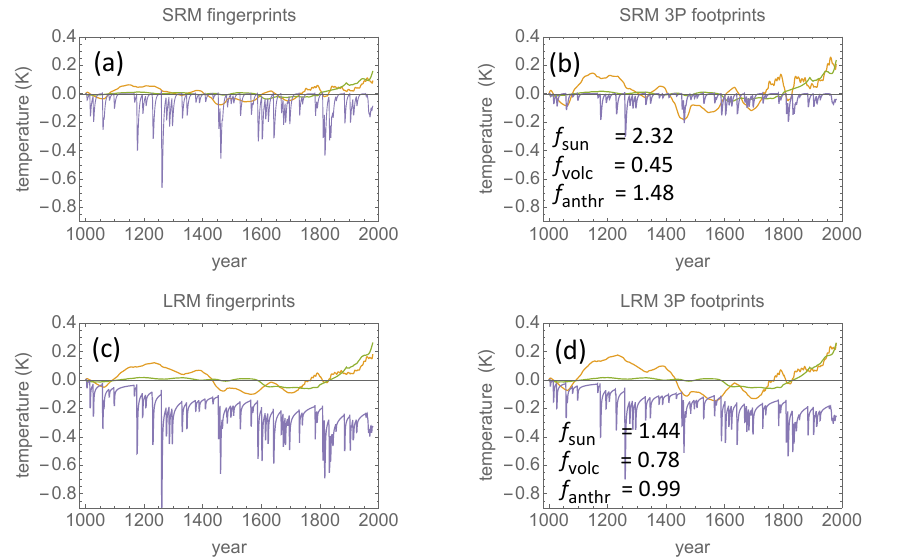
Figure 7. Fingerprints and footprints for the Northern Hemisphere temperature for 1000–1979CE. Panel (a) : the application of Eq. (6), with F being the SRM filter to the individual forcing components ( F sun ( t ) (yellow), F volc ( t ) (magenta), F anthr ( t ) (green)) to produce the fingerprints S ( t ), V ( t ), and H ( t ) for the SRM filter. Panel (b) : the footprints f sun S ( t ) (yellow), f volc V ( t ) (magenta), and f anthr H ( t ) (green) of SRM 3P regressed signal. Panel (c) : the same as in (a) but with the LRM filter. Panel (d) : the same as in (b) but with the LRM